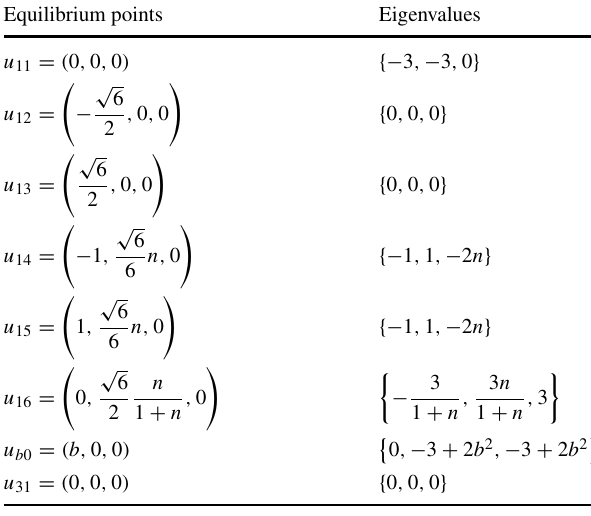
n )/ n . The phase portrait on the Poincaré sphere at infinity on local chart U 1 is shown in Fig.